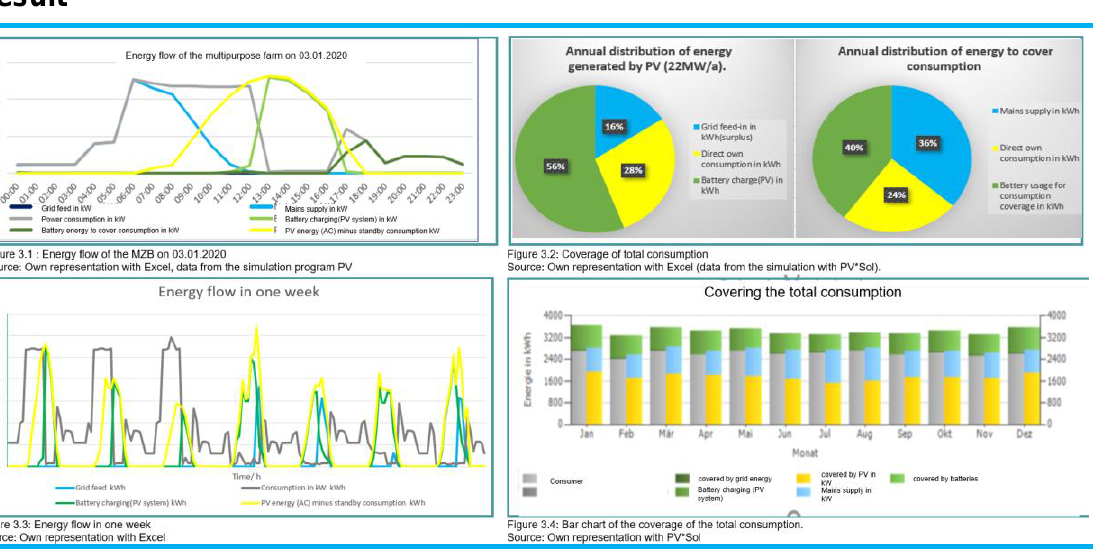
Figure 3 . Compilation of